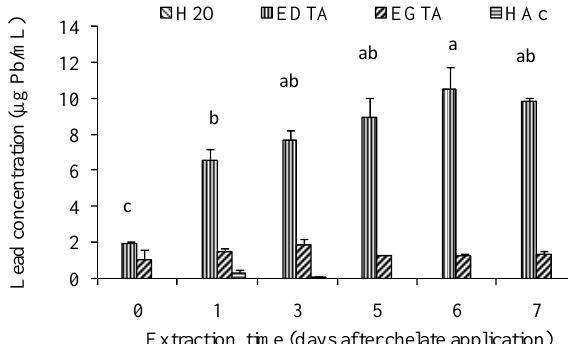
Figure 1: Lead solubility at various times after chelates application. Values and error bars represent means and standard errors of 3 replicates. Treatments with common letters do not differ significantly (Fisher's LSD, p < 0.05). Values not shown for a given extraction time indicates that Pb was not detected.